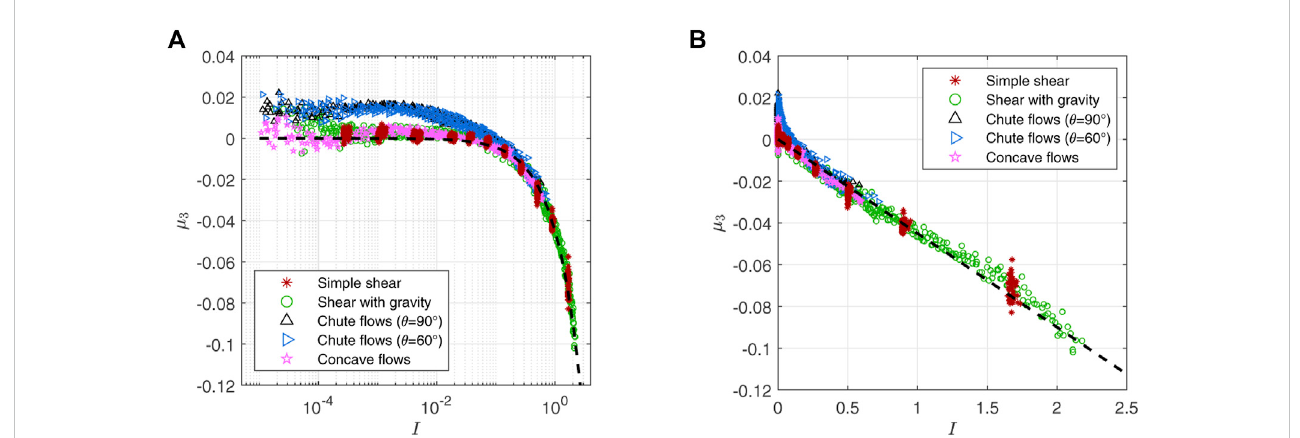
FIGURE 6 (A) μ 3 = ( σ xx − σ zz )/(4 P ) vs. I plot using a logarithmic scale on the I -axis. μ 3 is near zero for I < 0.1 except for chute fl ow data which go up to 0.02. (B) As I increases, μ 3 becomes negative and decreases almost linearly. Dashed trend lines in both plots indicate f 3 ( I ) = − 0.045 I